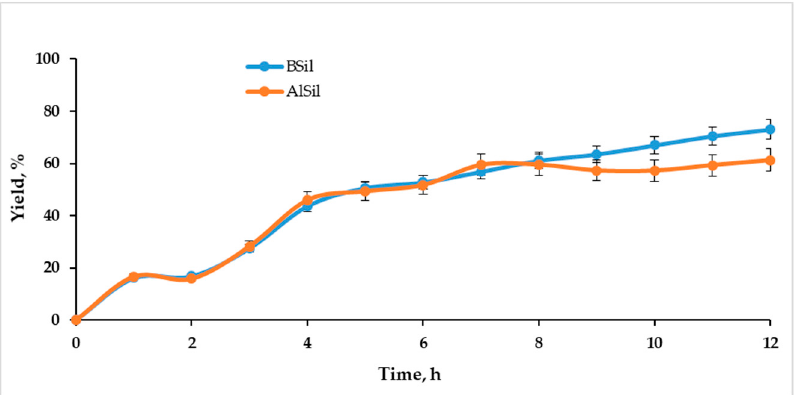
Figure 8. Efficiency of continuous OA esterification with methanol catalyzed by BSil and AlSil under ultrasonic activation.